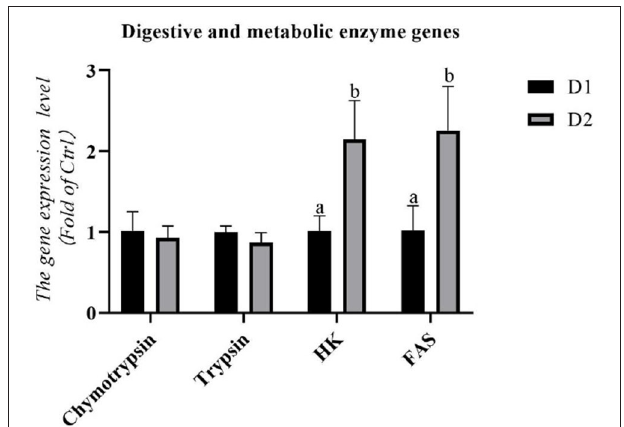
FIGURE 1 | Hepatopancreas RNA expression levels of antioxidant genes of Litopenaeus vannamei fed diets supplemented with/without Klebsormidium sp. for 56 days. a , b The small letters indicated significant differences at p < 0.05.